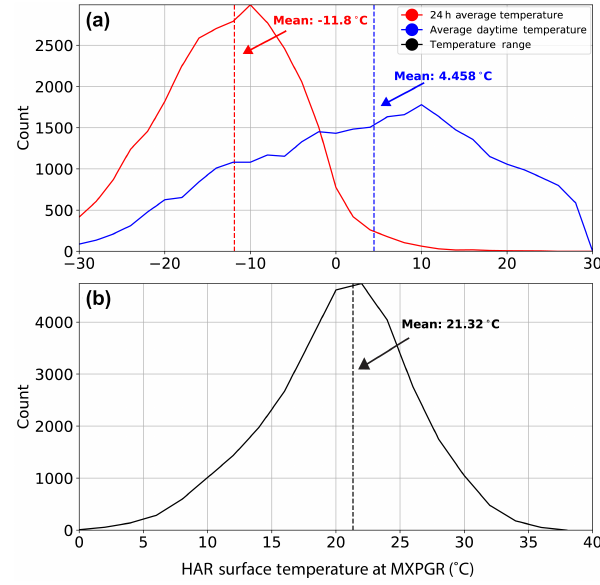
Figure 5. (a) HAR full-day average surface temperature (red), daytime average surface temperature (blue), and (b) daily surface temperature range (black) at the algorithm-derived MXPGR date ( n = 31583). Full-day and daytime average temperatures show dis- tinctly different distributions, with full-day temperatures averaging below 0 ◦ C and daytime temperatures above. This relationship, as well as the large daily temperature range, implies that the algorithm- derived MXPGR dates occur at or near the transition from subfreez- ing to above-freezing